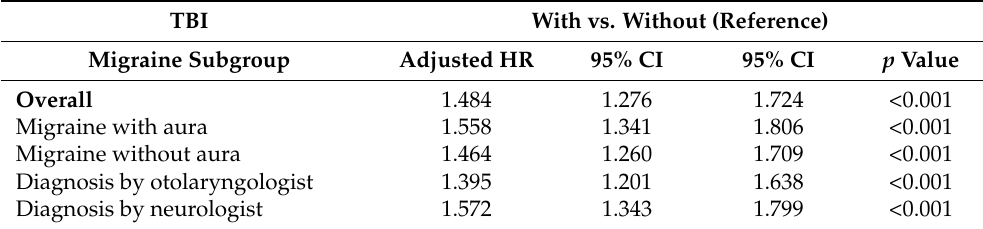
Table 3. Assessment of factors associated with migraine subgroups using Cox regression analysis. TBI With vs. Without (Reference) Migraine Subgroup